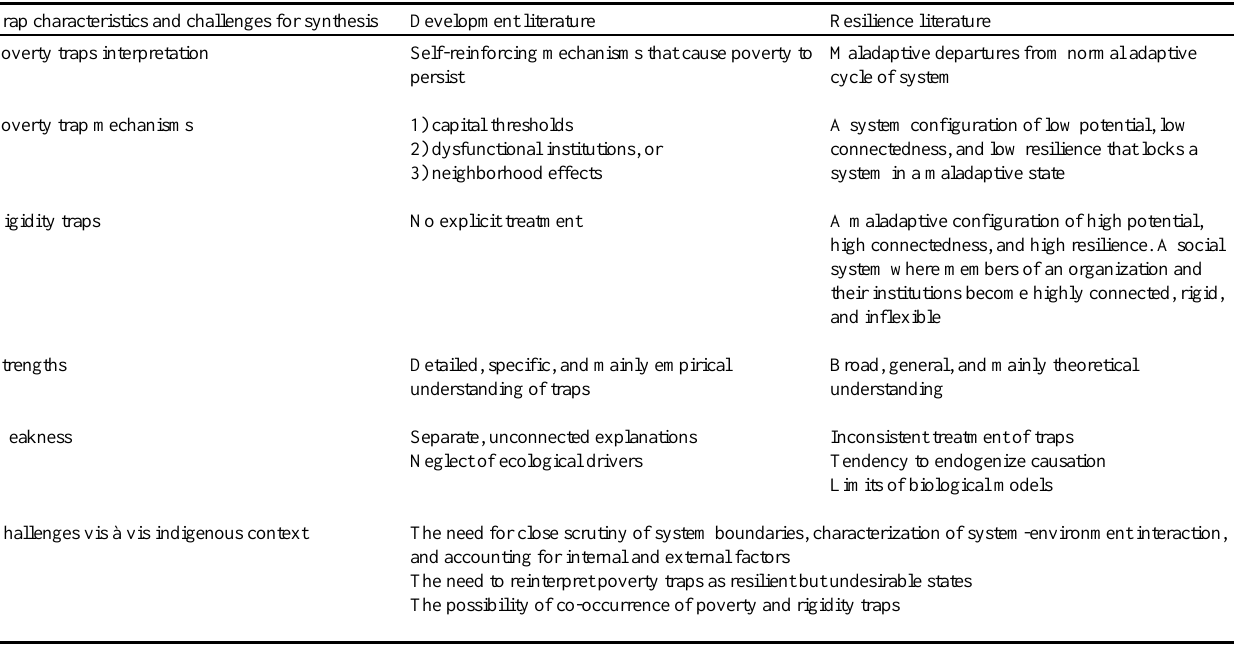
Table 3 . A summary of characteristics of trap conceptualization and mechanisms in the literature.